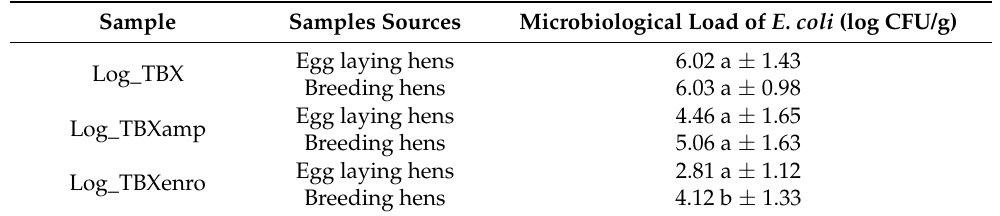
Table 1. Microbiological load of E. coli in TBX, TBX supplemented with ampicillin (TBXamp) or